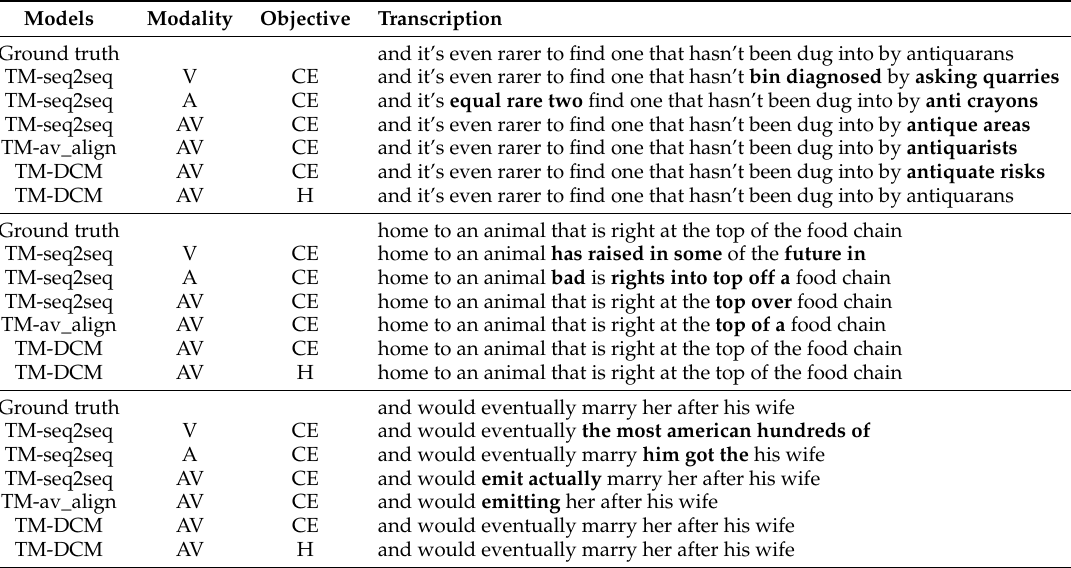
Table 3. Some decoding results for 0-dB-SNR noisy reverberant data. The boldface words denote wrong prediction. Abbreviation to understand the table: A, audio-only modality; V, video-only modality;